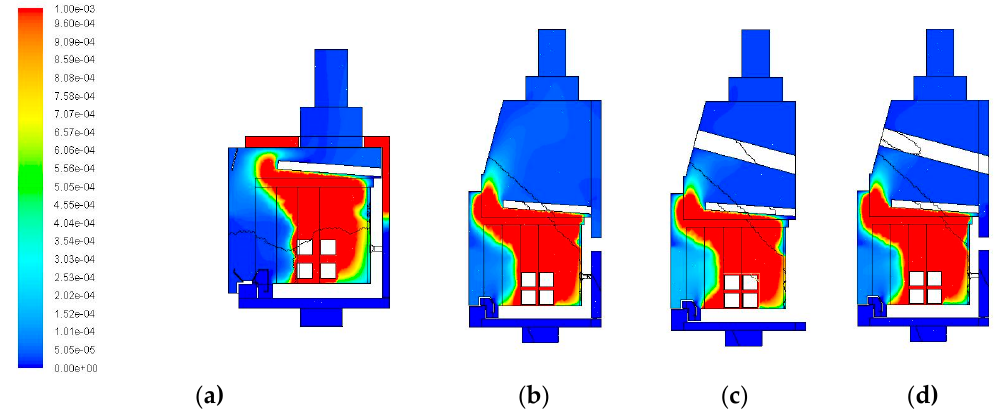
Figure 11. Concentration of CO (mole fraction) for ( a ) Case 0, ( b ) Case 1, ( c ) Case 2, ( d ) Case 3.